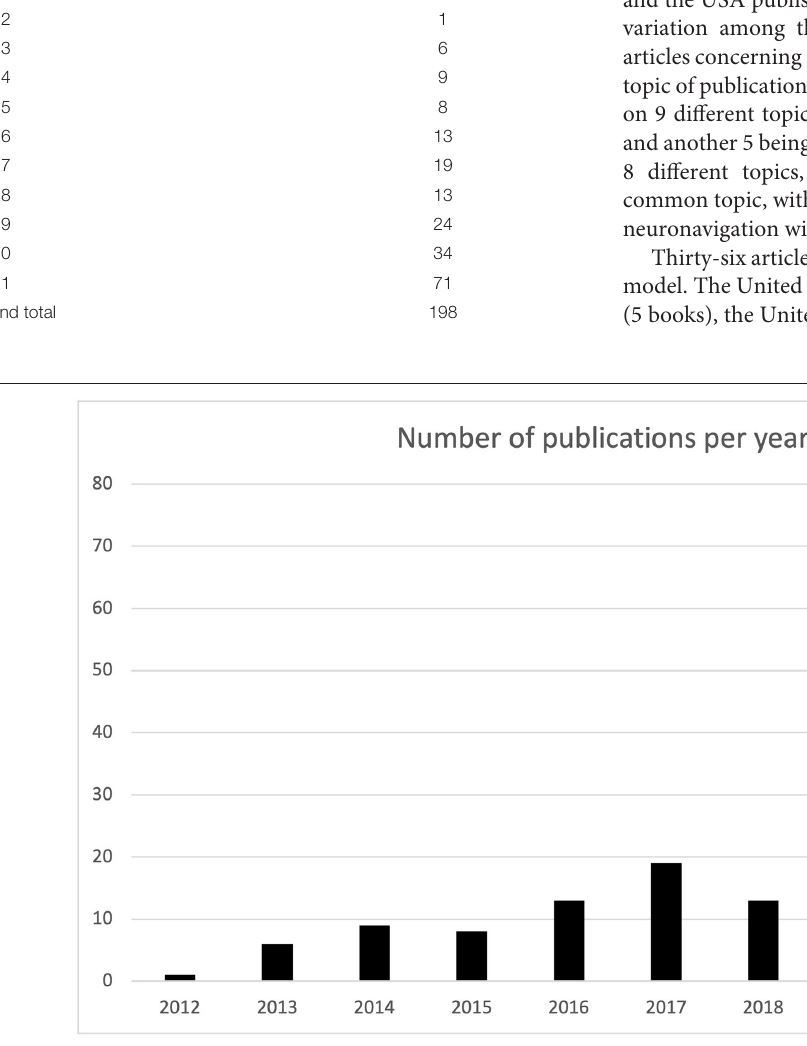
FIGURE 3 | Representation of the number of publication per country.